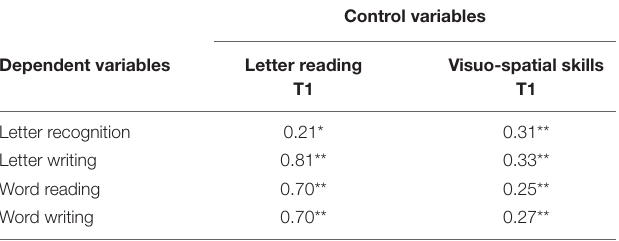
TABLE 3 | Correlations between dependent variables and control variables. In order to reduce complexity, dependent variables were collapsed across T2 and T3 and across